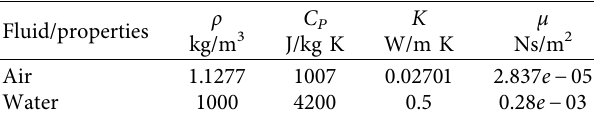
Figure 9: Water film thickness along the length of weir of R 6.47mm. Table 1: Thermophysical properties.